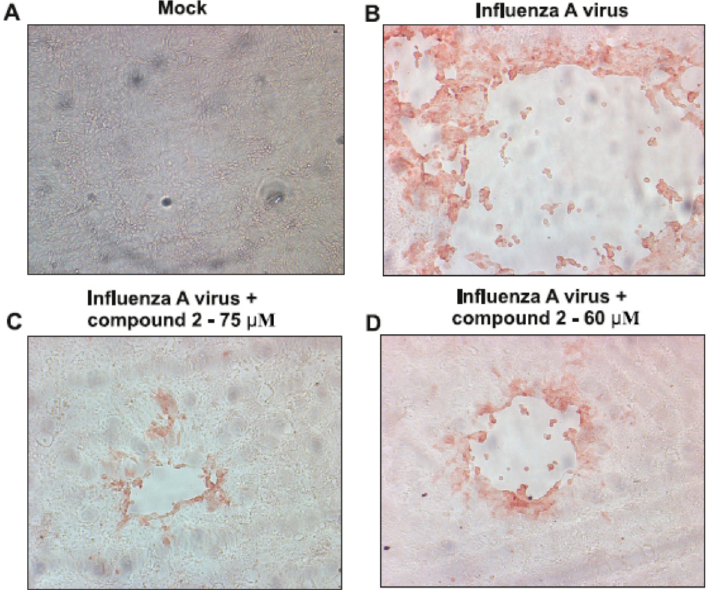
Figure 2. Reduction of influenza A virus-induced cytopathic effect by compound 2 . Madin-Darby canine kidney (MDCK) cells were not-infected ( A ) or infected with influenza virus A/ostrich/Denmark/725/96 (H5N2) ( B – D ). At 1 h p.i., the virus was removed and the cells were treated with 75 μ M ( C ) or 60 μ M ( D ) of compound 2 or left untreated (positive control— B ). 24 h p.i., the inhibitory effect of compound 2 on virus replication was evaluated by immunostaining using a monoclonal anti-M1 antibody. Images under a Nicon Eclipse TE300 microscope (Nicon Corporation, Tokyo, Japan) at 100× magnification.